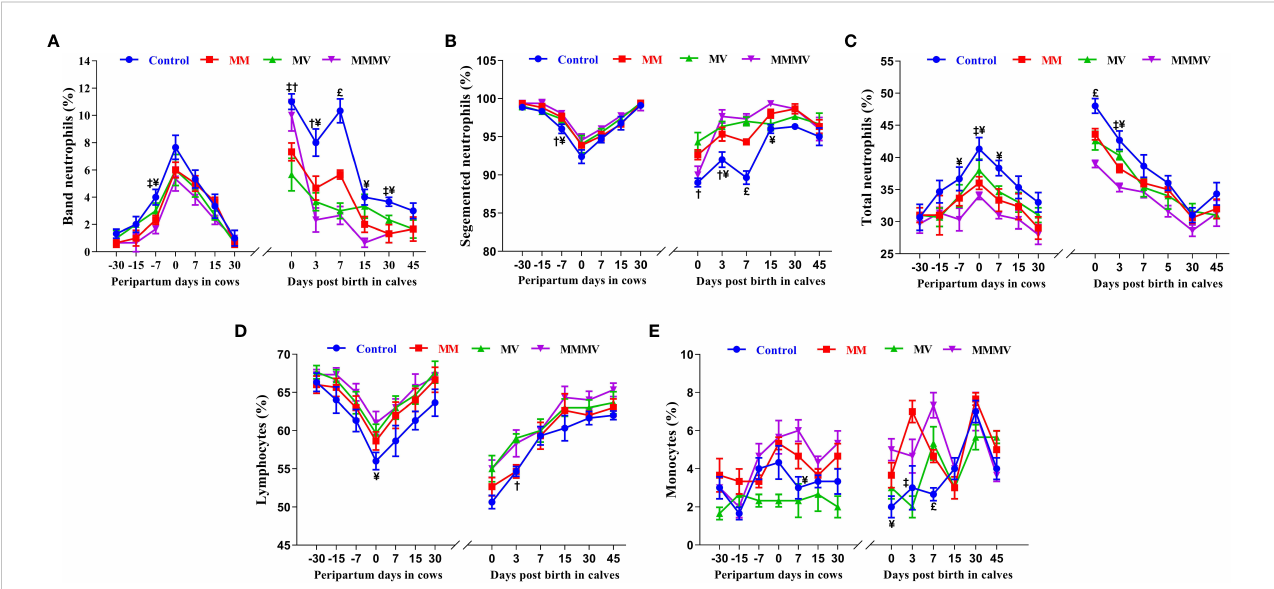
FIGURE 2 Blood differential leucocytes count including the percentage of band neutrophils (A) , segmented neutrophils (B) , total neutrophils (C) , lymphocytes (D) , and monocytes (E) in control and treatment groups of crossbred cattle and their calves. Control: received basal diet only, MM: basal diet + injectable multimineral, MV: basal diet + injectable multivitamins, MMMV: basal diet + combination of injectable multimineral and multivitamins. The mean values with different superscript symbols represent signi fi cant differences with control group at different days of peripartum in cows and post birth in calves; ‡ Control Vs MM, † Control Vs MV, ¥ Control Vs MMMV. £ Control Vs MM, MV and